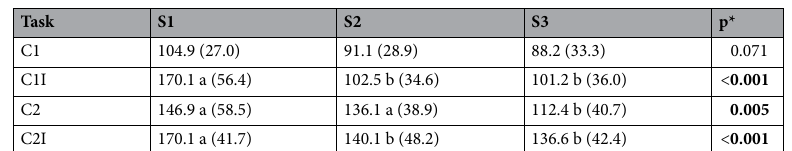
The participants’ performance results (drill time), as a function of the experimentation sessions are displayed on Table 1. As expected, drill time decreased steadily for all tasks with increasing prototype use. However, the decrease was not statistically significant for task C1 (p = 0.071). The performance results, recorded at experiment session S3, as a function of the participants characteristics and previous experience are displayed in Table 2. Overall, a higher performance is identified for participants with the following characteristics: female, non-gamer, no previous VR experience and with over 2 semesters of previous experience of working on phantom models. Significant differences are notably most present on task C1.